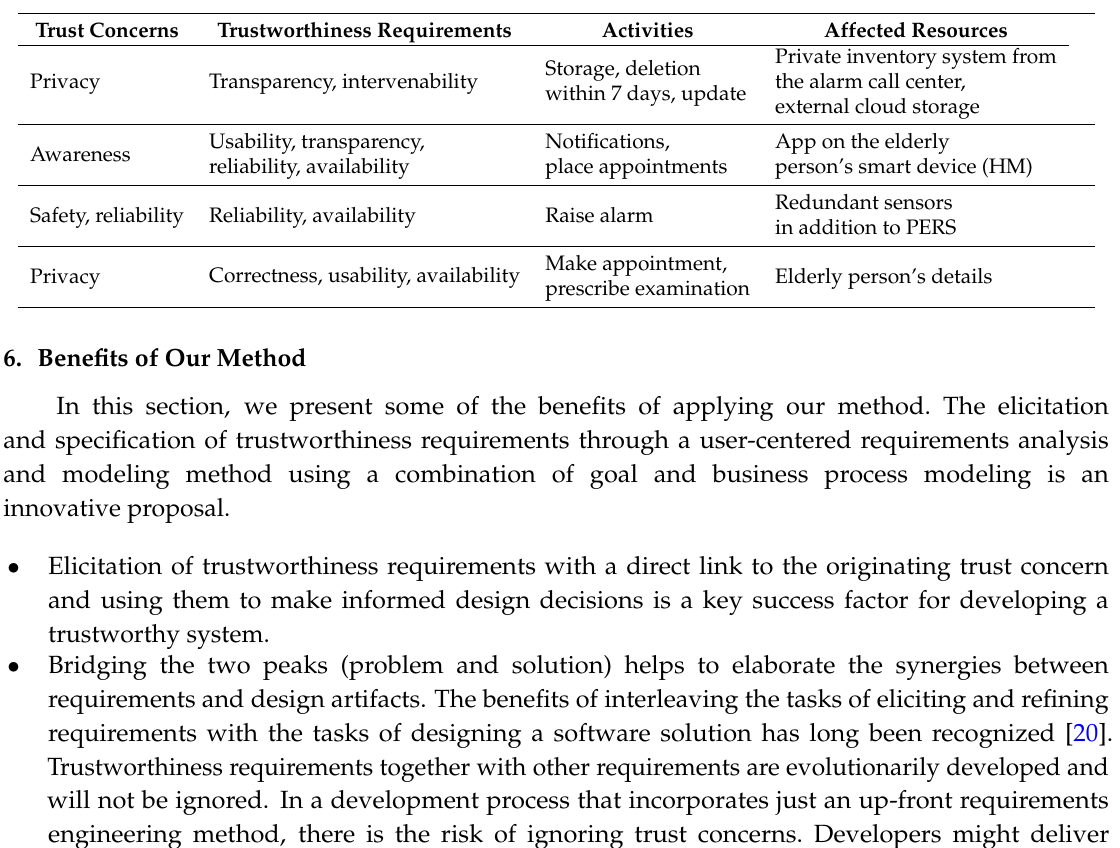
Table 2. Examples of captured trustworthiness requirements and properties in the business process and directions on the design